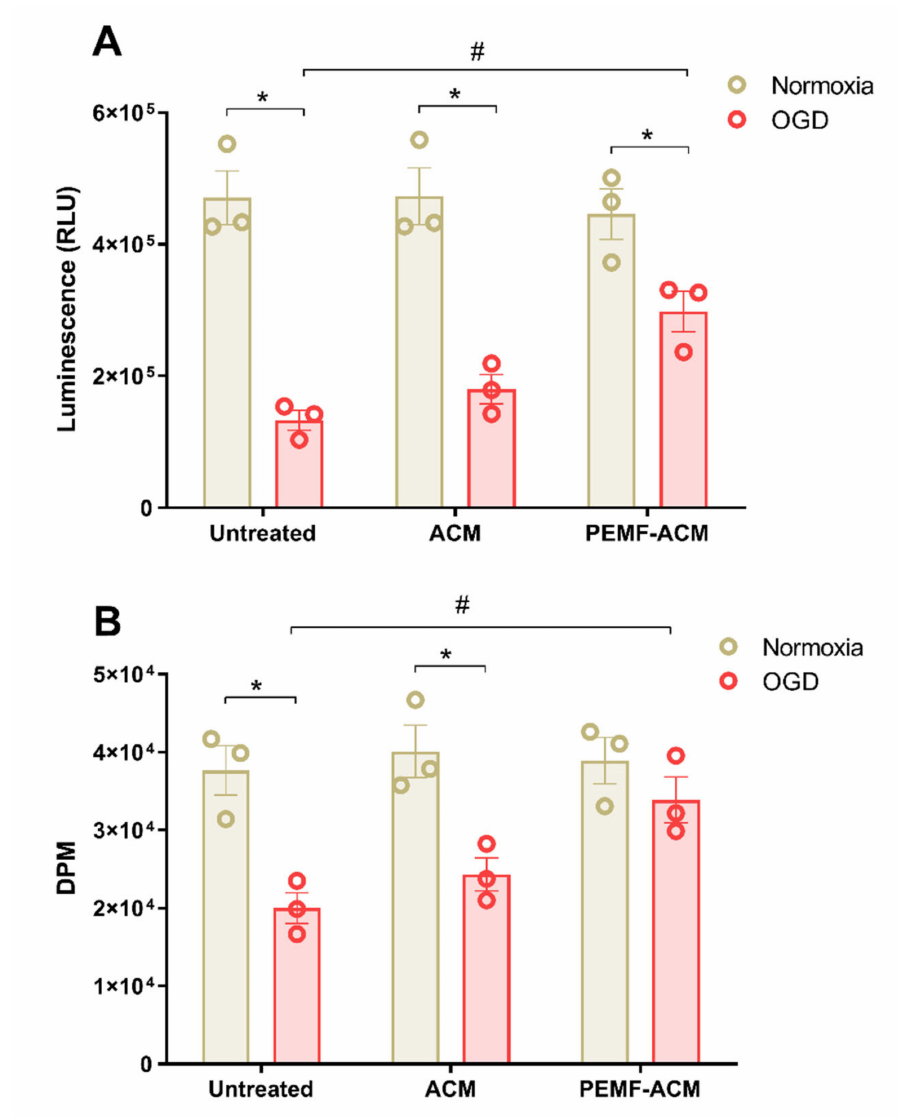
Figure 5. ACM derived from 1321N1 cells exposed to PEMFs confer protection to SH-SY5Y cells from OGD. ( A ) Luminescence expressed as relative light unit (RLU) proportional to ATP intracellular content as an index of SH-SY5Y cell viability. SH-SY5Y were cultured in normoxia or subjected to OGD in standard medium or the presence of 25% ACM derived from 1321N1 cells unexposed (ACM) and exposed to PEMFs in normoxia (PEMF-ACM). ( B ) Disintegrations per minute (DPM) proportional to the amount of [ 3 H]-Thymidine incorporation as an index of SH-SY5Y cell proliferation. SH-SY5Y were cultured in normoxia or subjected to OGD in standard medium or the presence of 25% ACM derived from 1321N1 cells unexposed (ACM) and exposed to PEMFs in normoxia (PEMF-ACM). Data are expressed as the mean ± SEM of three independent experiments. *, p < 0.01 vs. normoxia. #, p < 0.01 vs. untreated cells (standard medium) subjected to